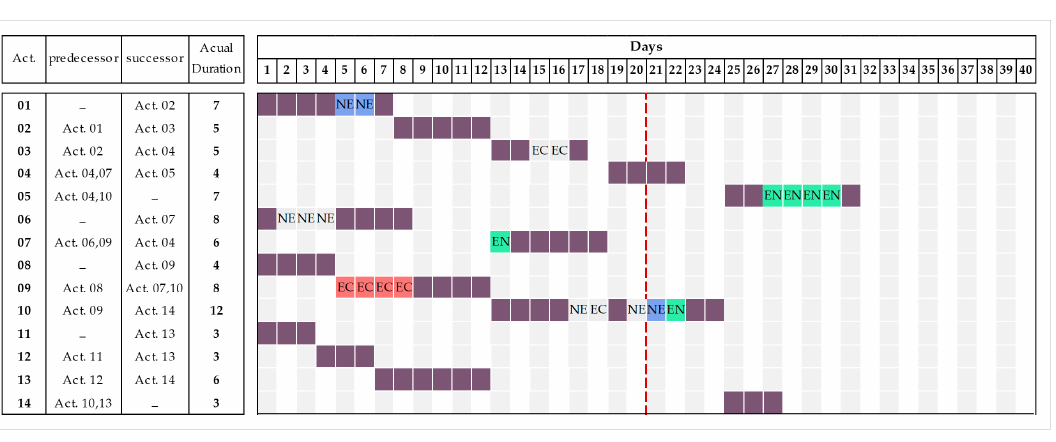
Figure 7. As-planned impacted schedule, period (27–30). Table 6. The results of period (27–30) into the project delays.